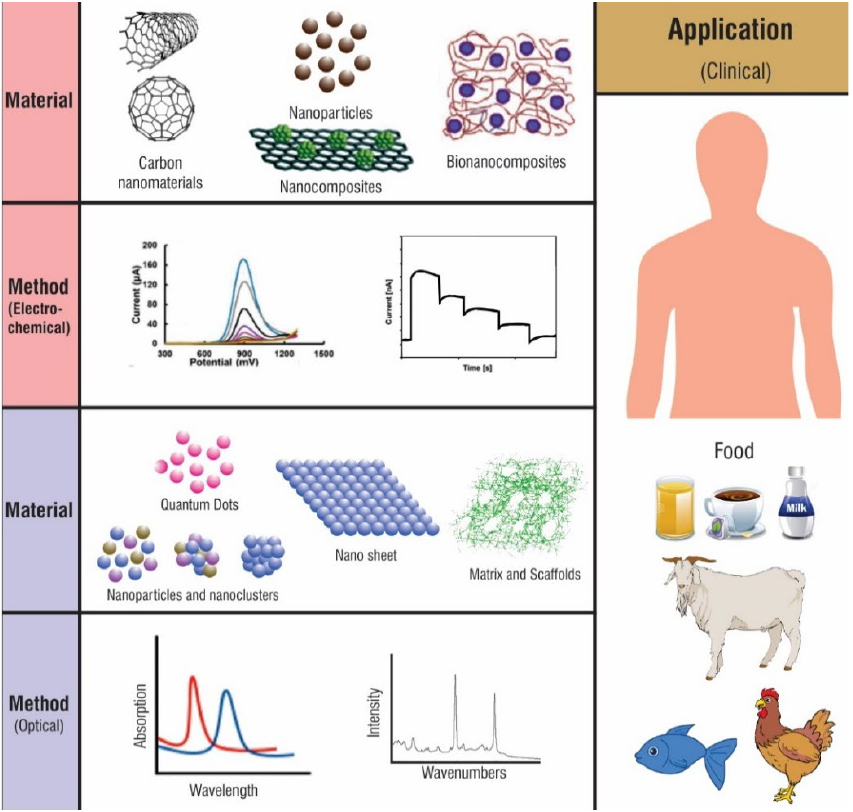
Figure 11. Schematic representation of the possible application of CNMs implemented in biosensing applications